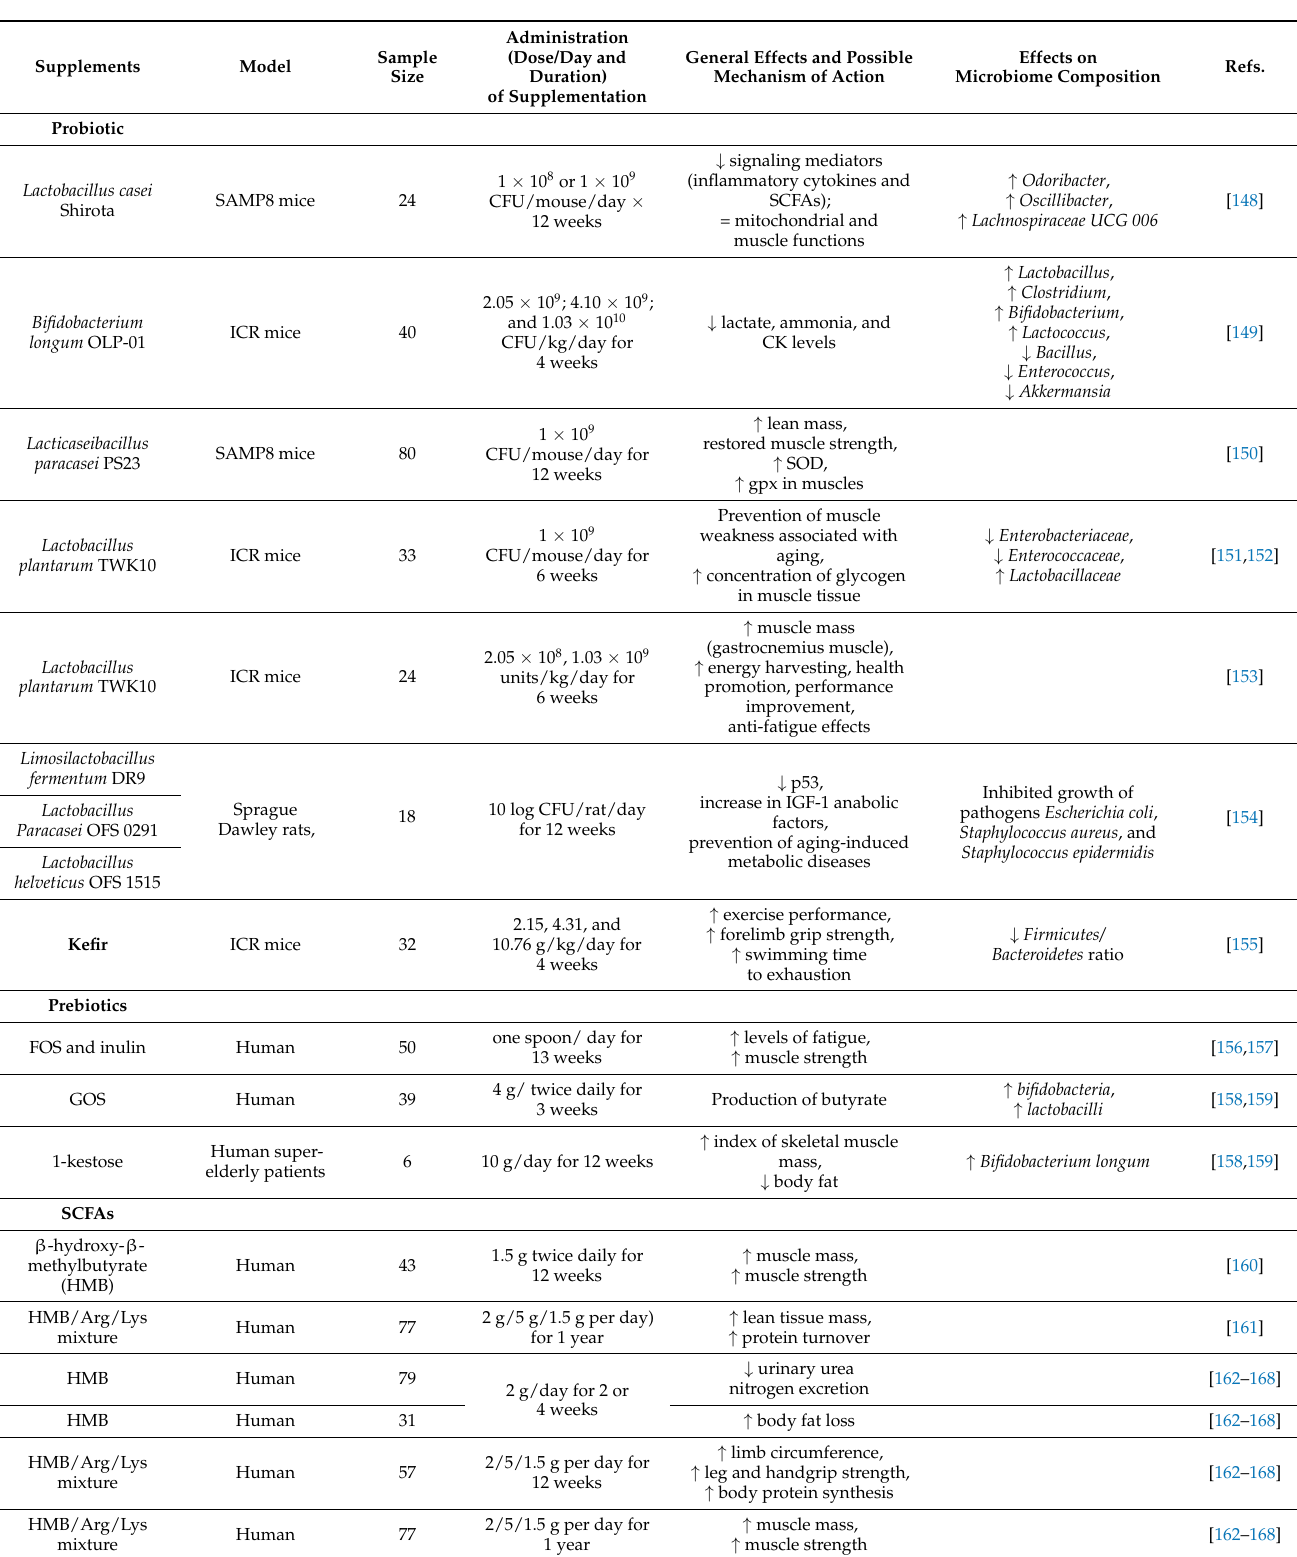
Table 1. Supplements demonstrating efficacy through specific doses able to maintain musculoskele- tal